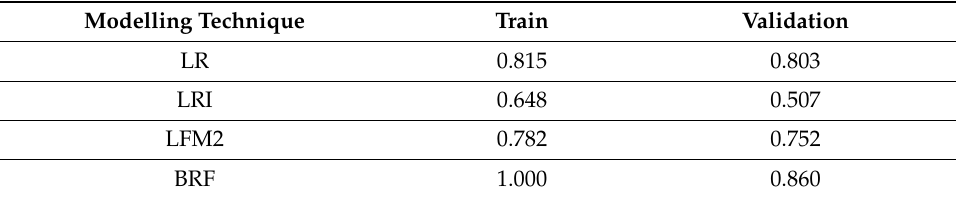
Table 13. F1 scores obtained by the various models on the full data set.